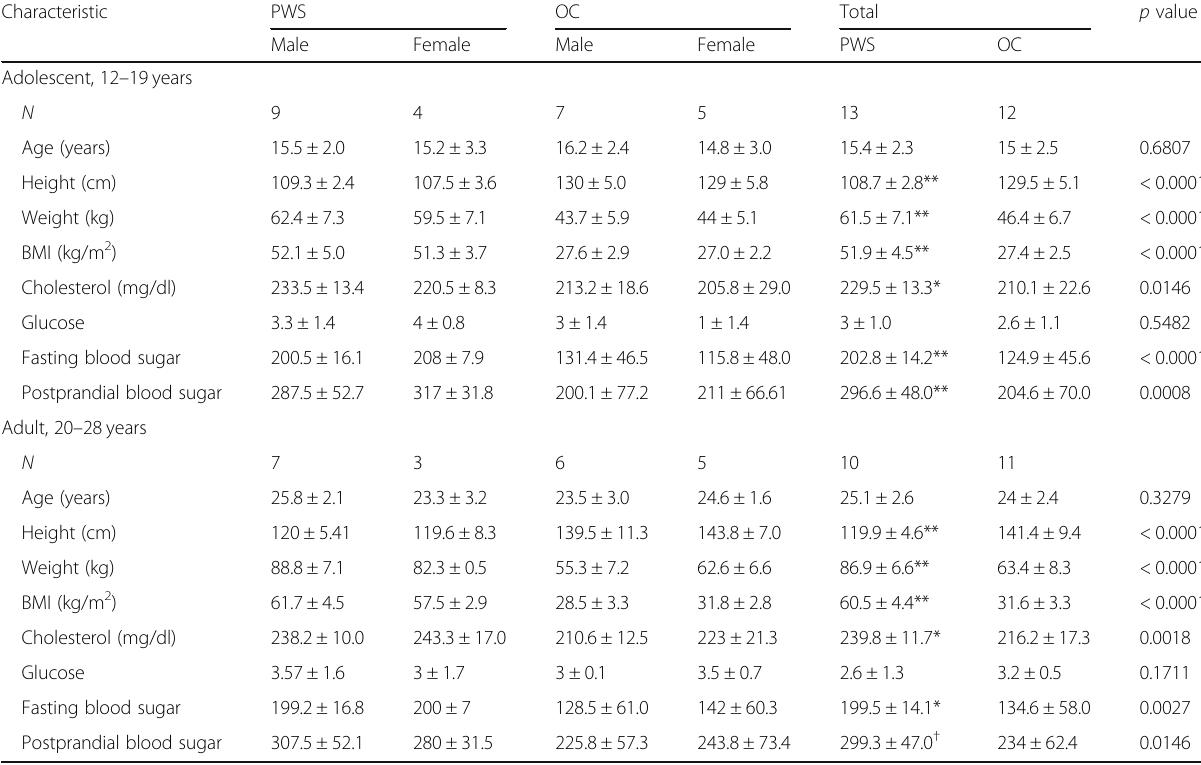
Table 2 Comparison of physical and biochemical parameters between PWS and OC subjects Characteristic PWS